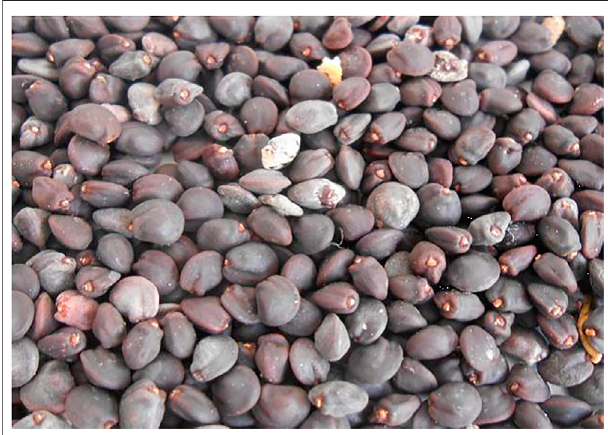
FIGURE 2 | Seed sample of Dodonaea plant